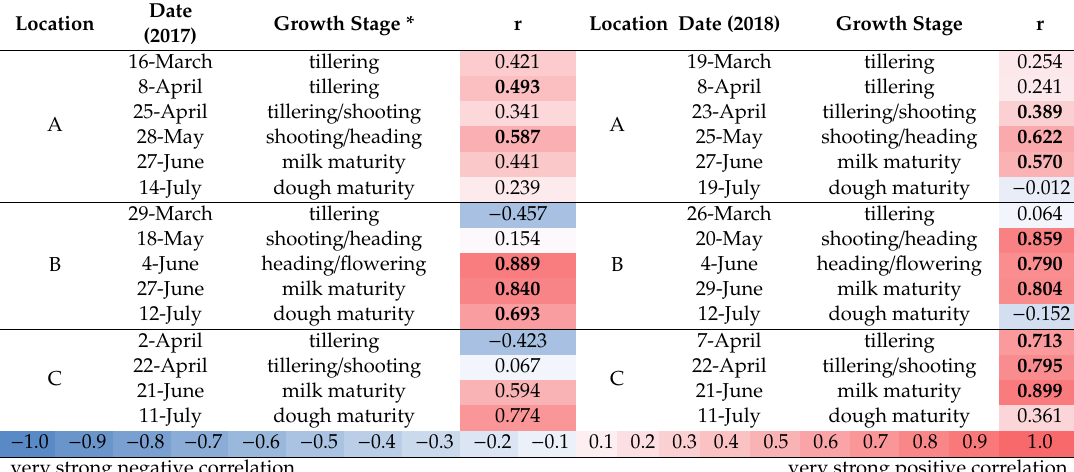
Table 5. Correlation coe ffi cients (r) between NDVI values and grain yield (t · ha − 1 ) for three locations in 2017 and 2018. The background color of the cells with the correlation coe ffi cient values indicates the strength of the relationship (significant correlations at α = 0.05 are given in